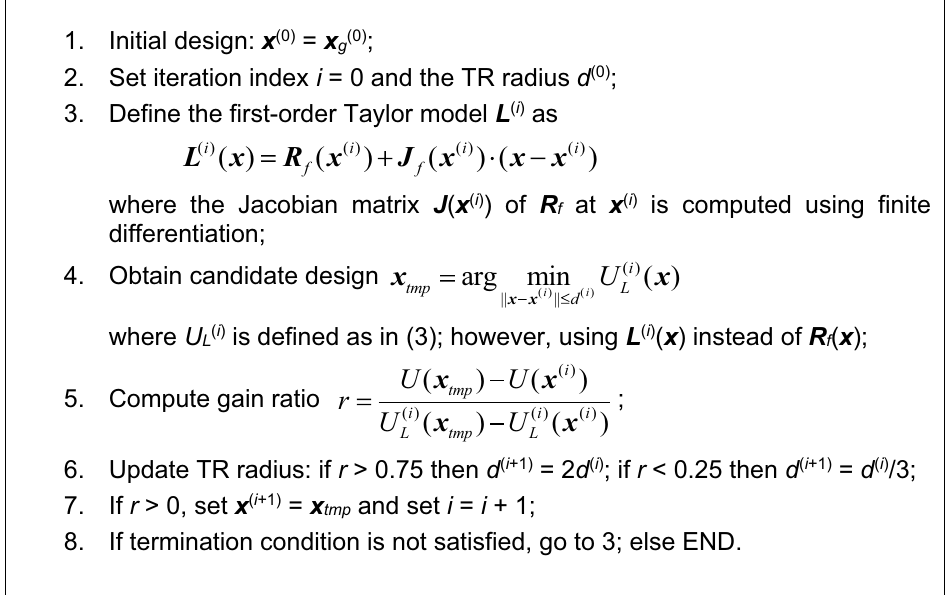
Figure 6. Formulation of the trust-region gradient-based algorithm. The termination condition is based on convergence in argument, || x ( i +1) – x ( i ) ||< ε , and reduction of the TR radius, d ( i ) < ε (whichever occurs first). The termination threshold ε is set to 10 −3 for final tuning of the high-fidelity model, but it is relaxed to 10 −2 for low- fidelity optimization runs.